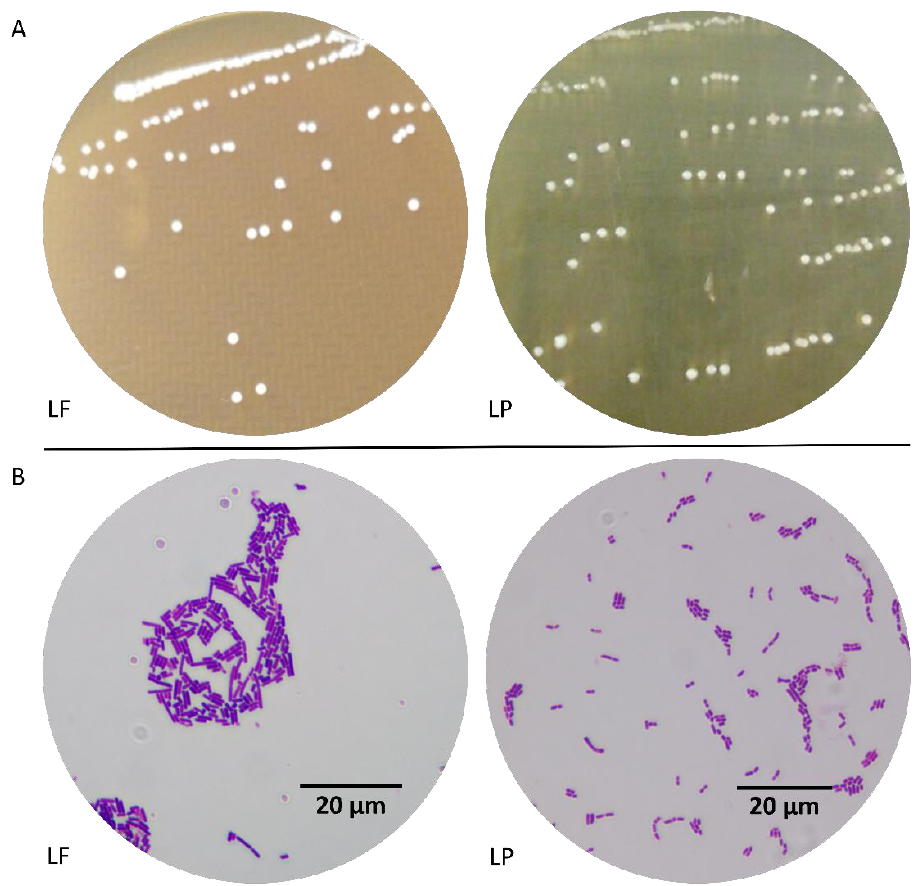
Figure 2. Morphological characteristics. ( A ) Colony morphology, ( B ) Cell morphology (×1000). LF: Lactobacillus fermentum ; LP: Lactobacillus plantarum .